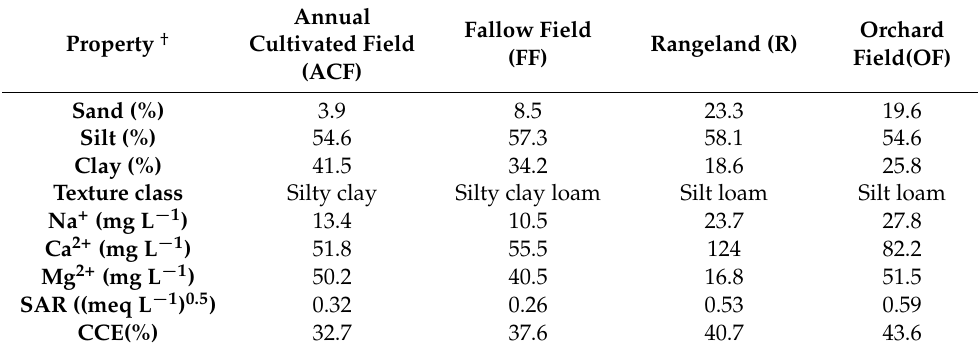
Table 1. Mean of some soil physico-chemical properties in different studied land-use